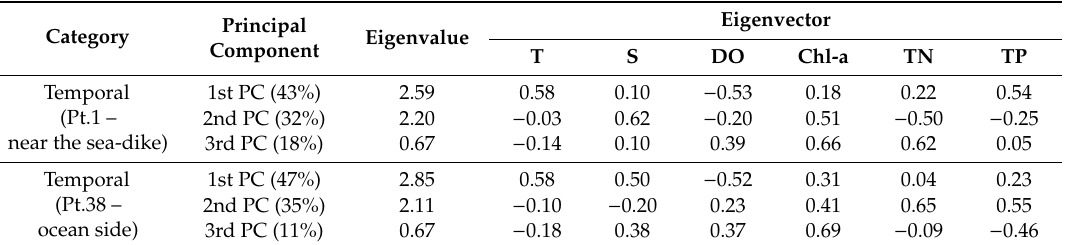
Table 2. The results of the EOF corresponding to the PCs for the temporal